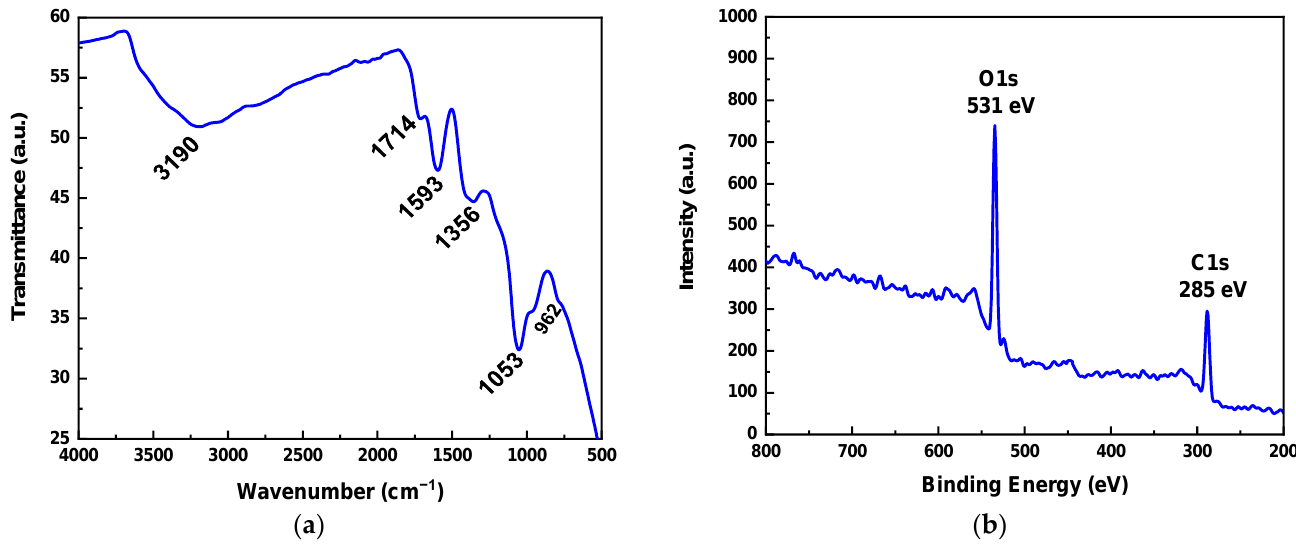
Figure 1. ( a ) ATR-IR FT-IR spectrum; and ( b ) XPS spectrum of graphite oxide powder synthesized via improved Hummers’ method. Table 1. % Concentration of carbon components present within the structure of graphite oxide derived from the C1s peaks deconvolution.